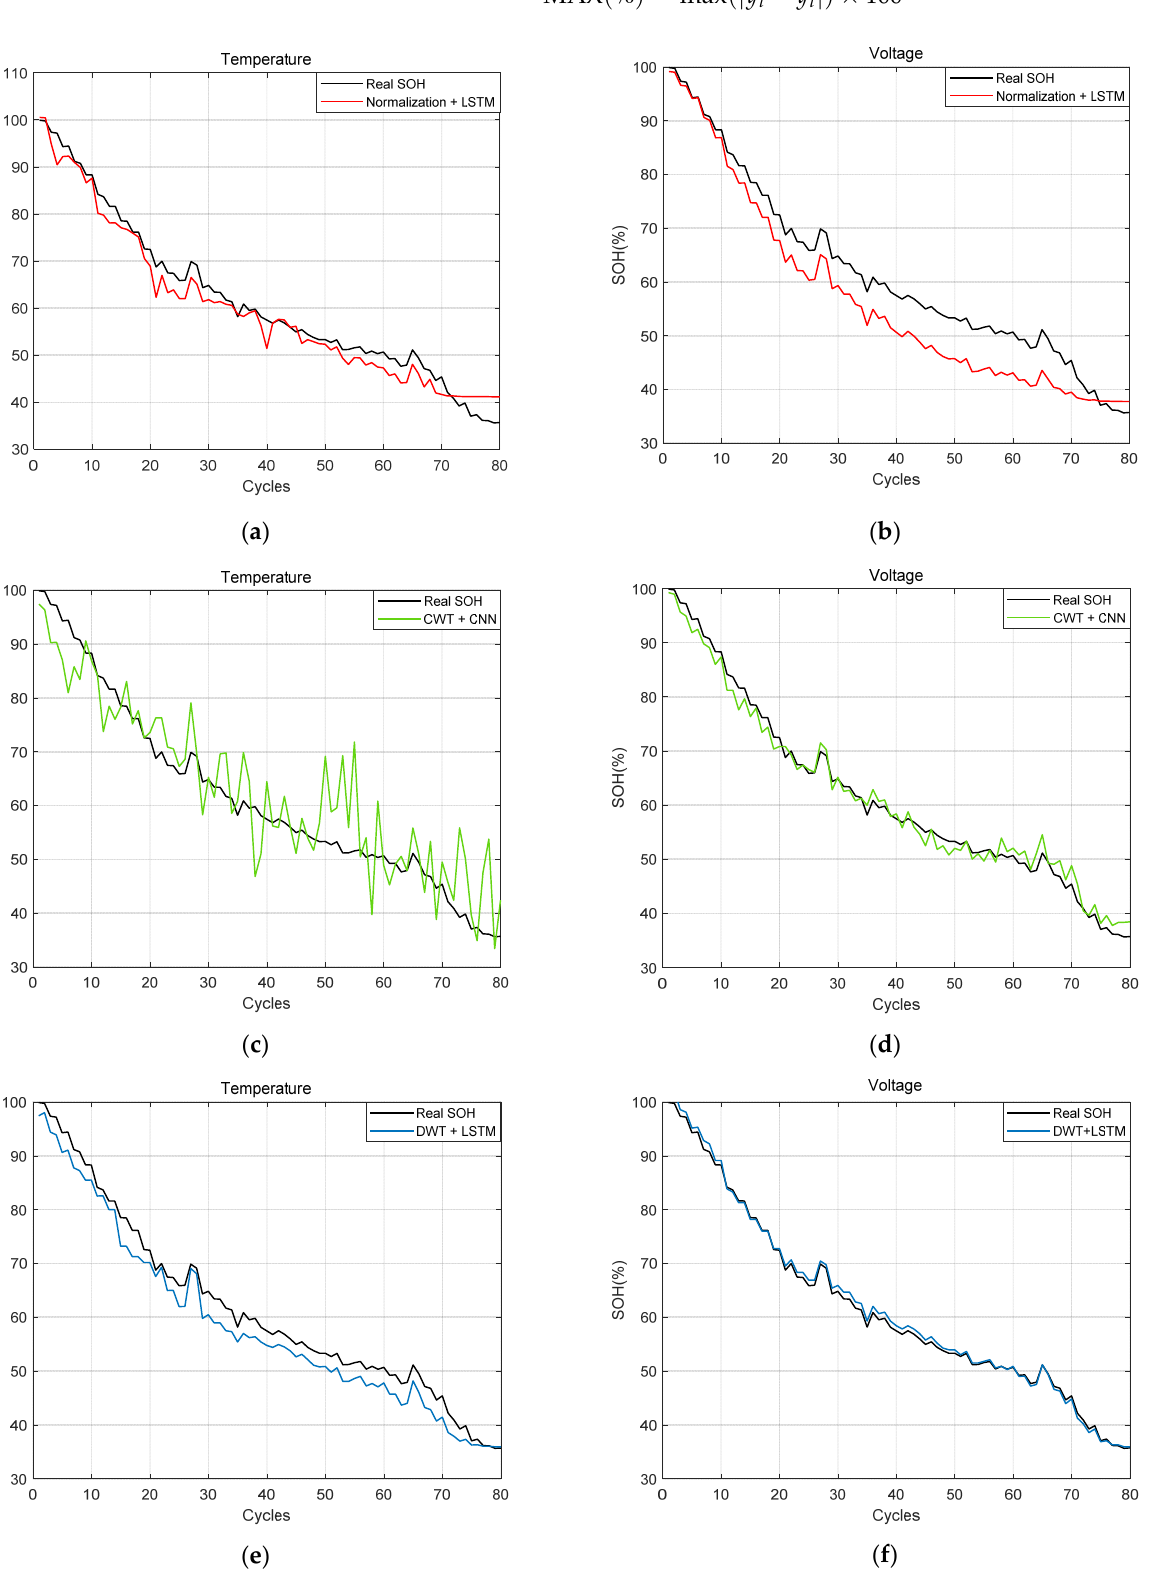
Figure 9. SOH estimation results: ( a , b ) are normalization + LSTM, ( c , d ) are CWT + CNN and ( e , f ) are DWT + LSTM.